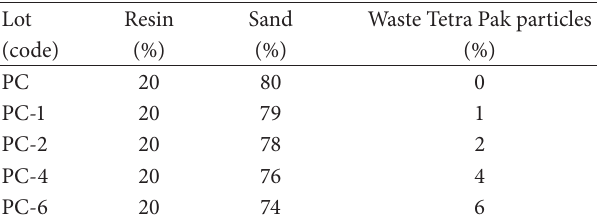
Table 1: Polymer concrete